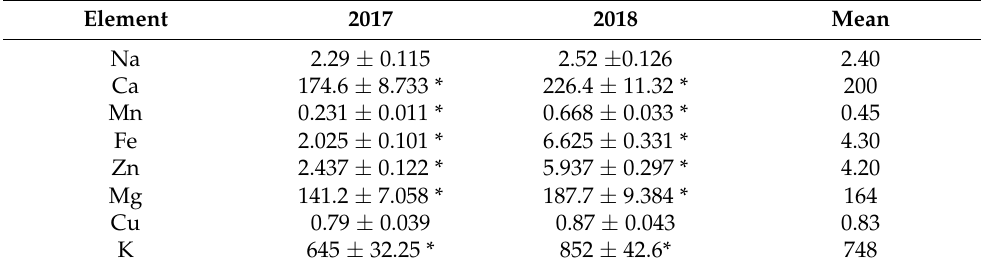
Table 2. Mineral element content (expressed on dry-weight basis (mg/100 g)) in the chickpea seeds, sampled during two years (2017 and 2018). Data are mean ± SD. *, significant differences ( p < 0.05), see main